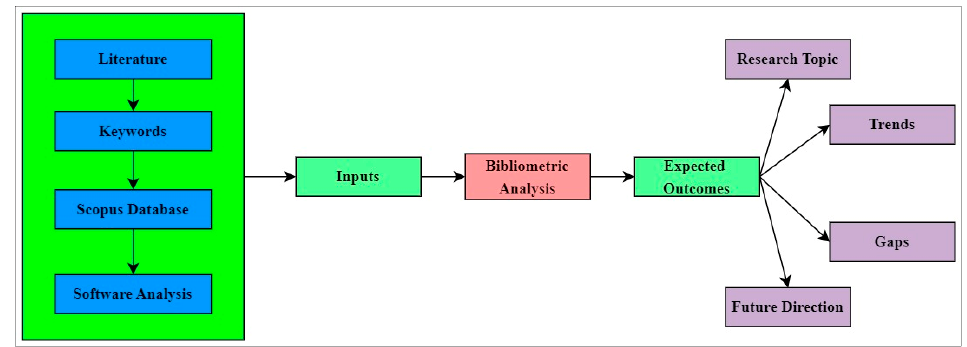
Figure 2. Outcome of bibliometric analysis.